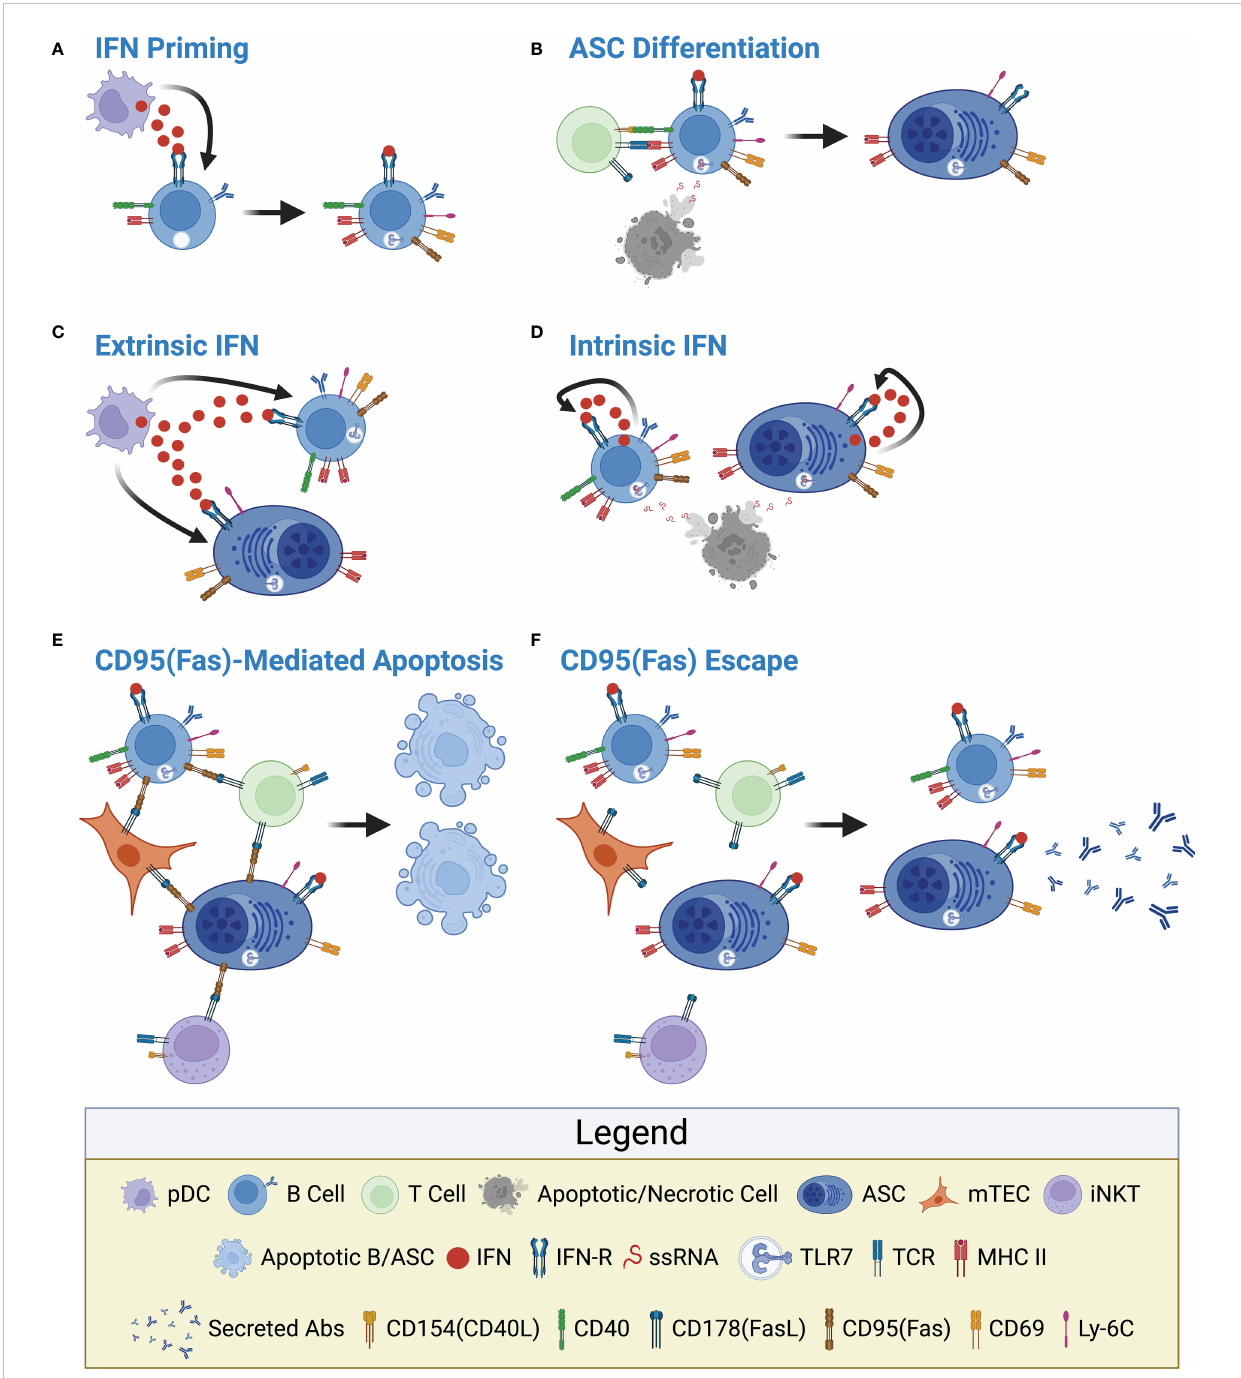
FIGURE 2 Hypothetical model depicting interferon-mediated regulation of thymus B cells and antibody-secreting cells. (A) IFN Priming: IFNs secreted by cells such as pDCs directly induce expression of TLR7, CD69, CD95(Fas), Ly-6C and MHC II by THY B cells. This could be driven by Type I, II and/or